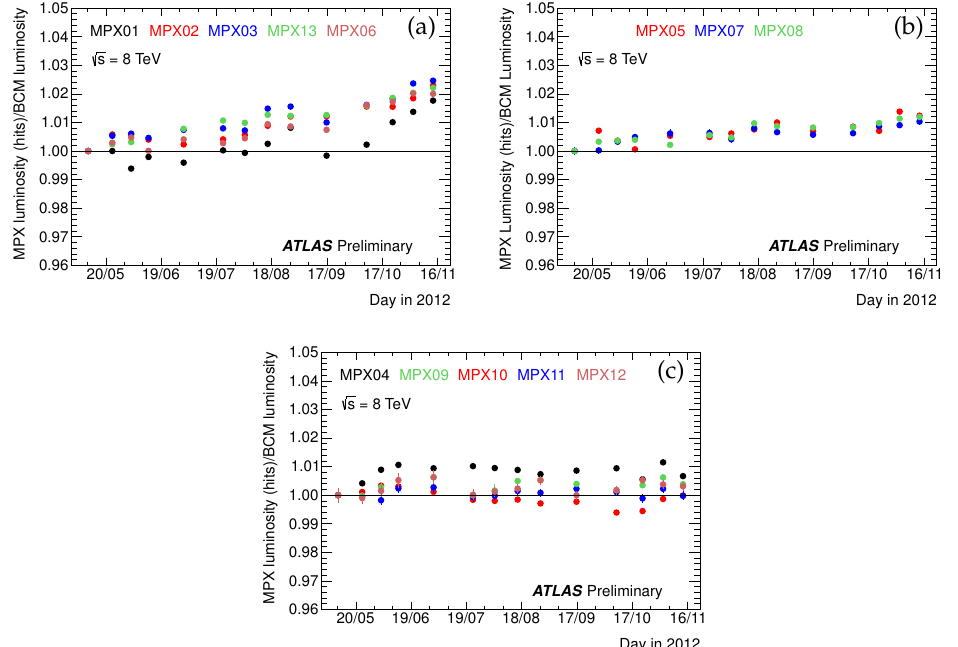
Figure 23. Fractional deviation of the luminosity reported by different MPX devices from the ATLAS reference luminosity (BCM) as a function of time in 2012. The ratio is shown for 14 time periods. For each device, the time periods are chosen to have the same number of frames. The statistical uncertainties are comparable to or smaller than the size of the markers. The data are scaled such that the value of the first bin is unity. Taken from Ref.